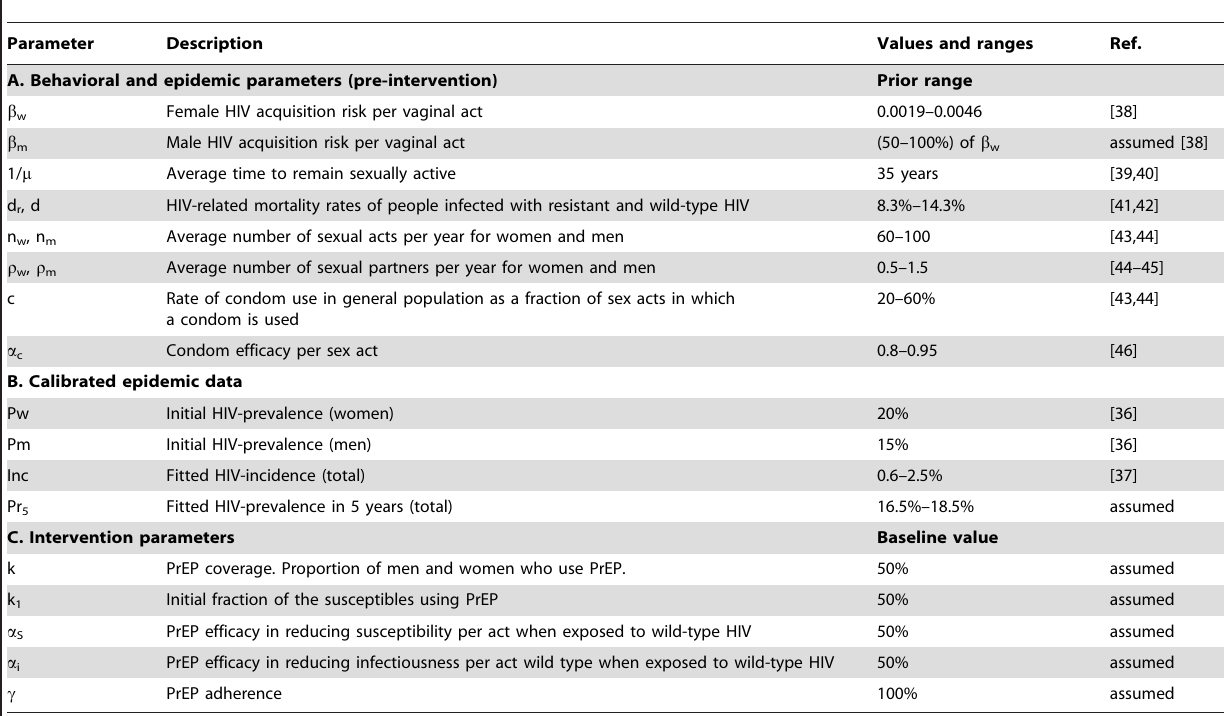
Table 1. Parameters and ranges used in the analysis.